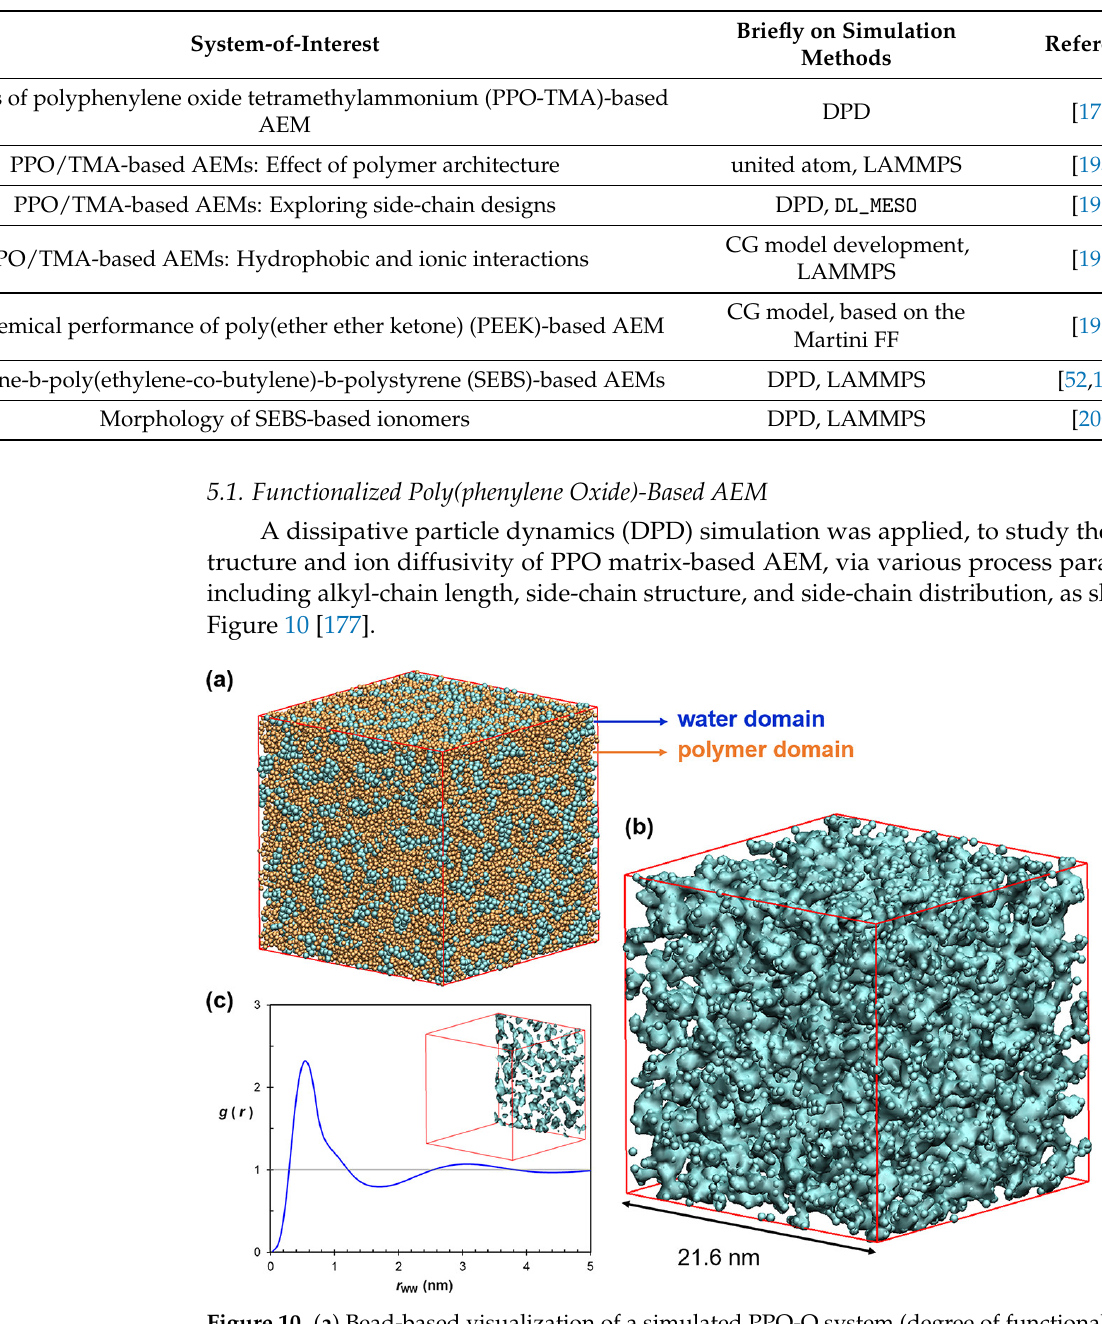
Figure 10. ( a ) Bead-based visualization of a simulated PPO-Q system (degree of functionality: